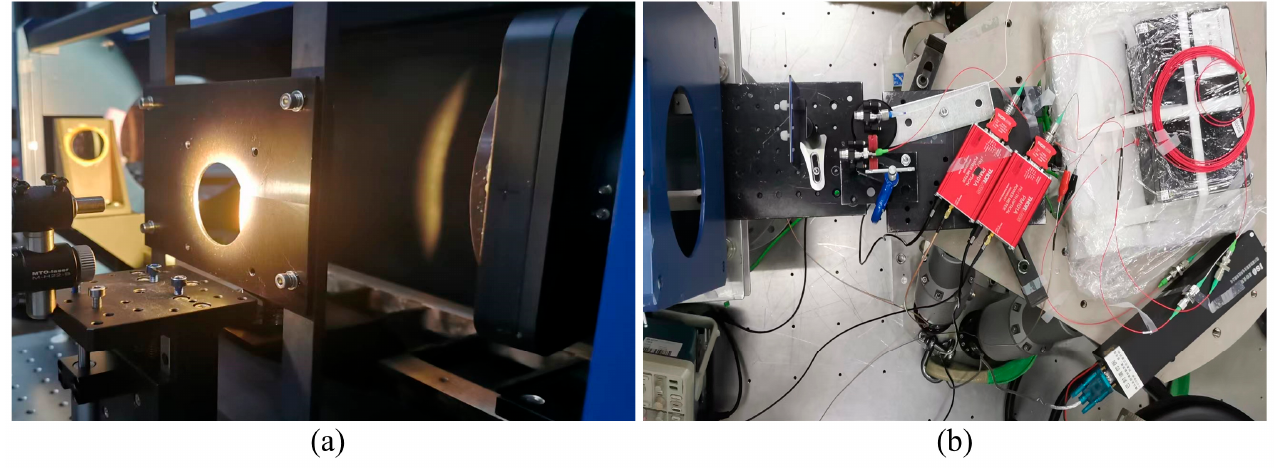
Figure 6. Photographs of the experimental setup: ( a ) light source, collimator with 2.27 m focal length; ( b ) filter, fiber patch cable, fiber stretcher, motorized delay line, coupler, detectors.